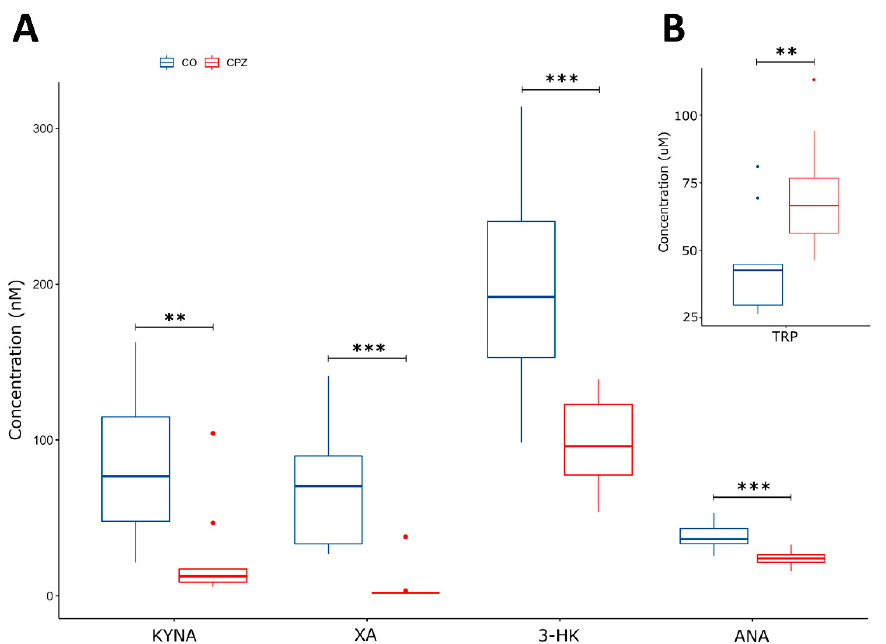
Figure 4. Alteration in plasma metabolite levels at week 5 of CPZ treatment. In addition to the KYNA, 3-HK, and XA (nM), we also observed a significant difference in the concentration of ANA (nM) ( A ) and TRP (µM) metabolites ( B ) by the 5th week of CPZ treatment between CO and CPZ groups. CO: control group; CPZ: cuprizone group: 3-HK: 3-hydroxy-L-kynurenine; ANA: anthranilic acid; KYNA: kynurenic acid; TRP: tryptophan; XA: xanthurenic acid; w: week; **: p < 0.01; ***: p < 0.001.